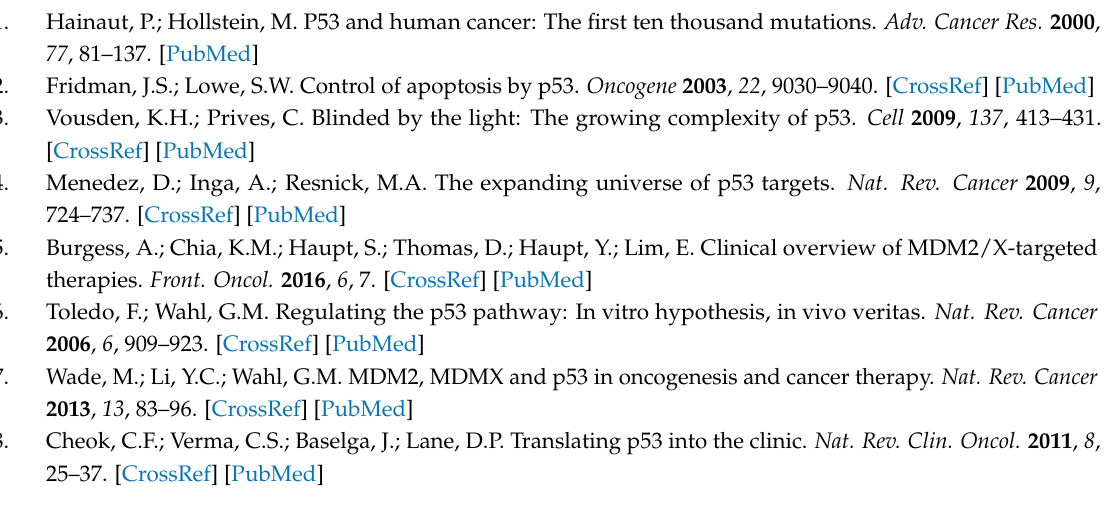
Supplementary Materials: Figure S1. Activity-guided fractionation of the methanol extract and isolation of active principles. Figure S2. The structure of all flavonoids used in Figure 4. Figure S3. Chemical structure of